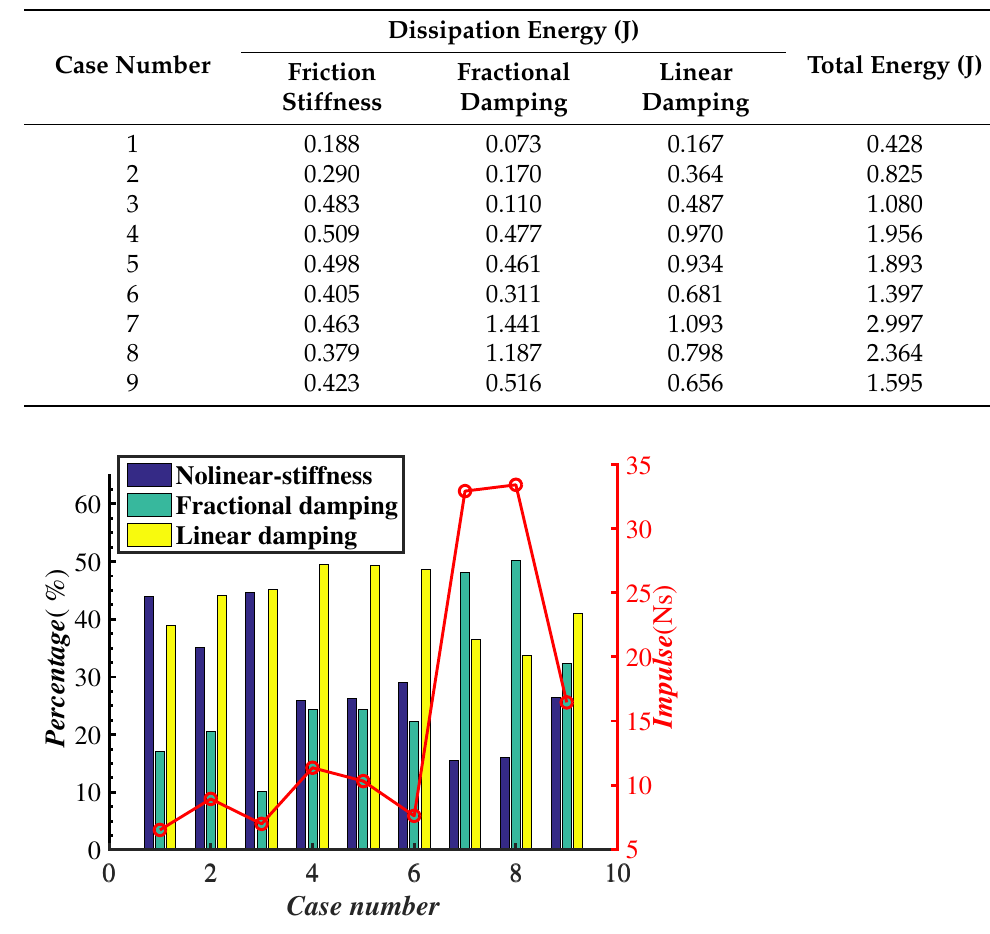
Figure 13. Relationship between the dissipation energy and input impulse for different